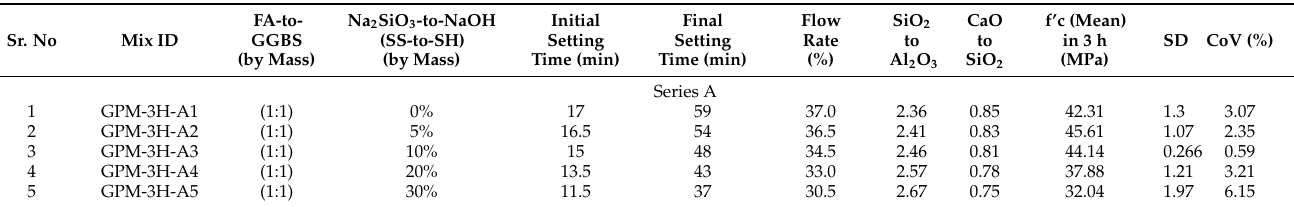
Figure 14. Geopolymer material initial setting time using various Na 2 SiO 3- to-NaOH and FA-to-GGBS ratios with sand preheated at 110 ◦ C. Table 6. Setting time, flow rate, compressive strength, standard deviation (SD), and the coefficient of variation (CoV) of the GPM using various Na 2 SiO 3 -to-NaOH and FA-to-GGBS ratios with sand preheated at 110 ◦ C and cured in a hot oven at 50 ◦